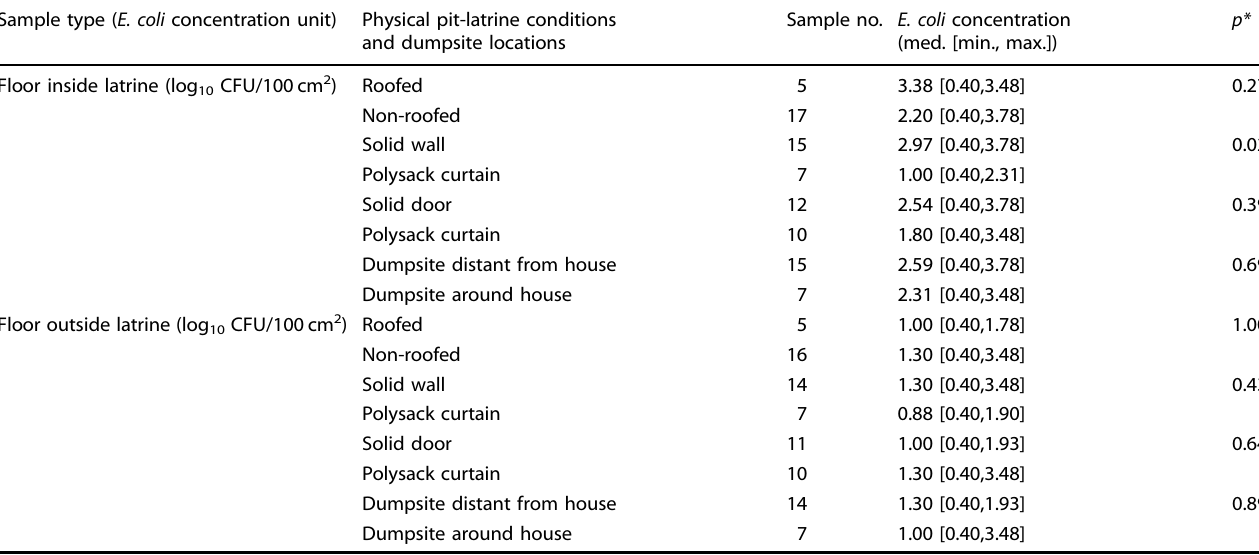
Table 2. Impacts of physical pit-latrine conditions and dumpsite location on E. coli concentration of fl oors inside and outside latrines. Sample type ( E. coli concentration unit) Physical pit-latrine conditions and dumpsite